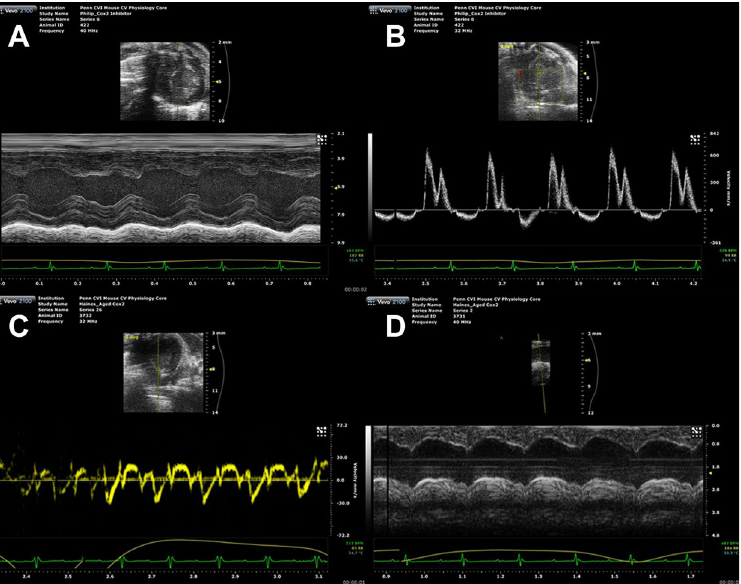
Figure 1. ECG 2D and Doppler imaging measurements. ( A ) M-mode imaging of the LV mid-papillary level in the parasternal short-axis view. ( B ) Mitral valve inflow velocities were recorded by Doppler ECG in the apical 4-chamber view. ( C ) LV myocardial velocities were recorded by TDI in the apical 4-chamber view. ( D ) AADs and AADd were measured in M-mode imaging. * AADs ascending aorta diameters at end-systole; A ADd ascending aorta diameters at